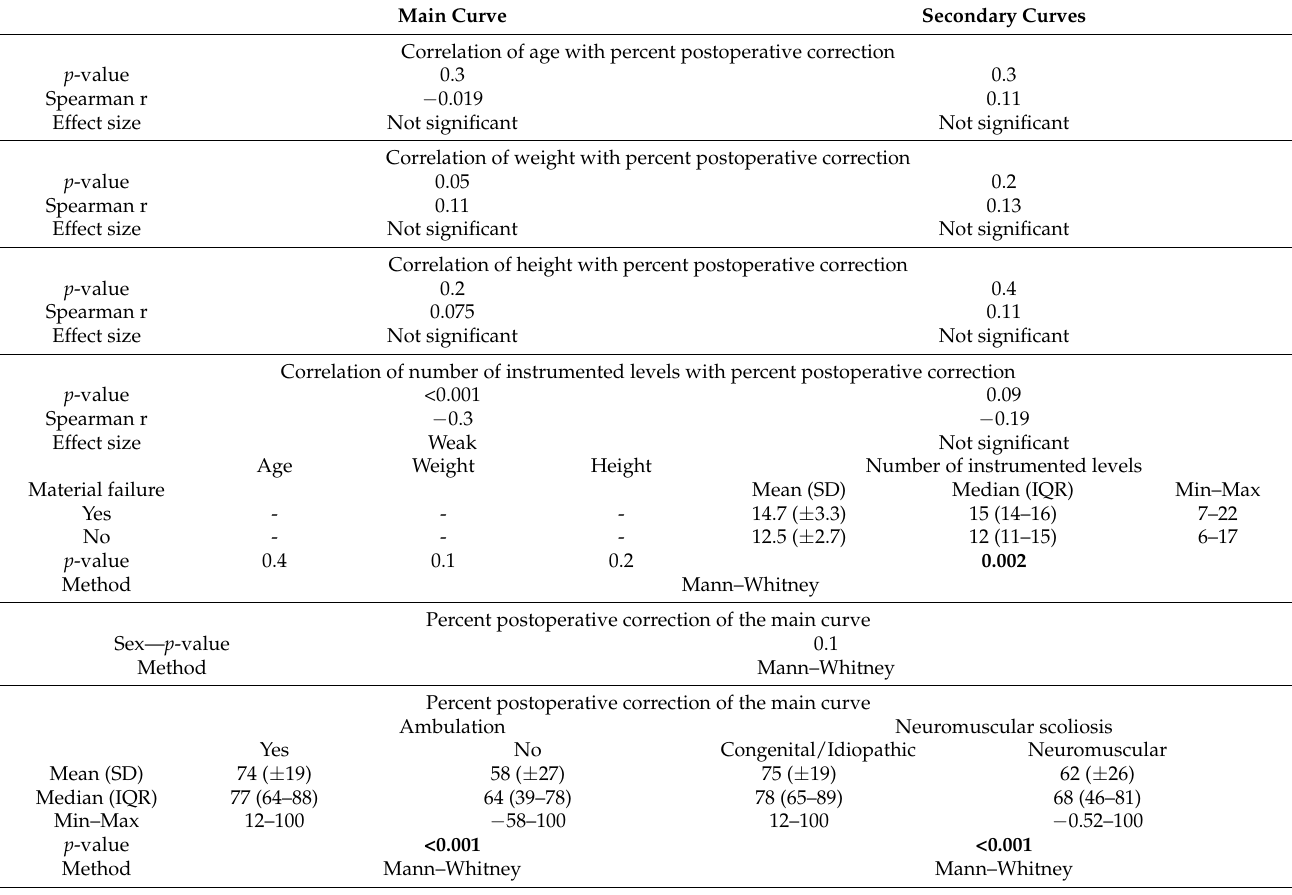
Table 5. Correlation of age, weight, height and number of instrumented levels with percent scoliotic curve correction, and material failure and association of sex, neuromuscular etiology and iliac fixation with material